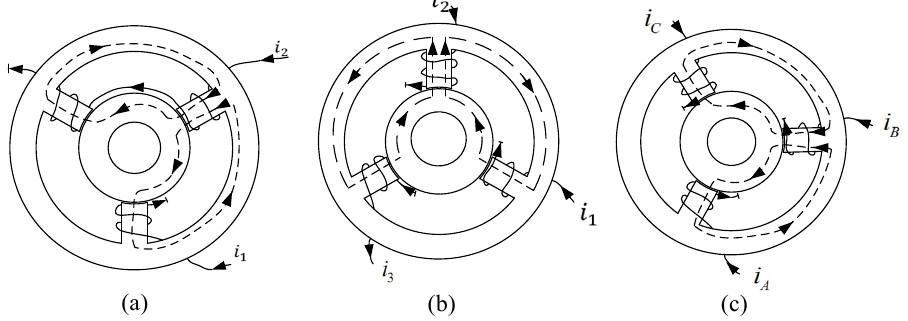
Figure 4. The 3 ‐ pole RMB structure. ( a ) Two power amplifier drive models. ( b ) Three ‐ power ampli ‐ Figure 4. The 3-pole RMB structure. ( a ) Two power amplifier drive models. ( b ) Three-power amplifier fier drive models. ( c ) Three ‐ phase drive models. drive models. ( c ) Three-phase drive